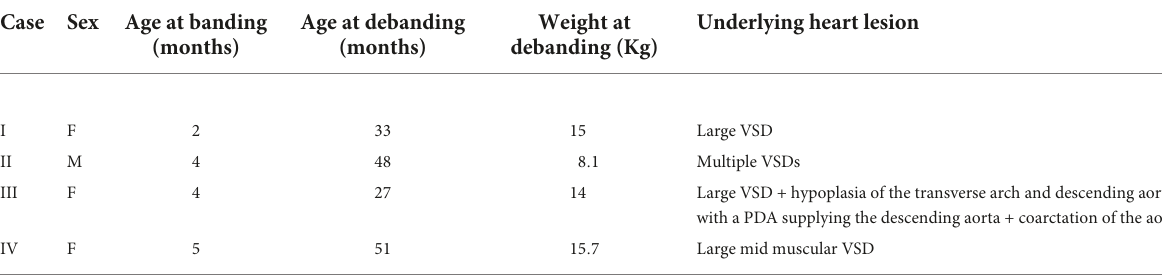
TABLE 1 Demographic characteristics of the patients.